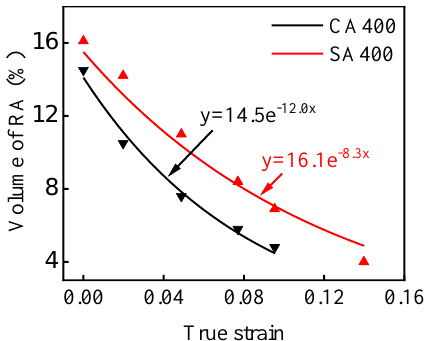
Figure 7. Variation in volume fraction of austenite with true strain.